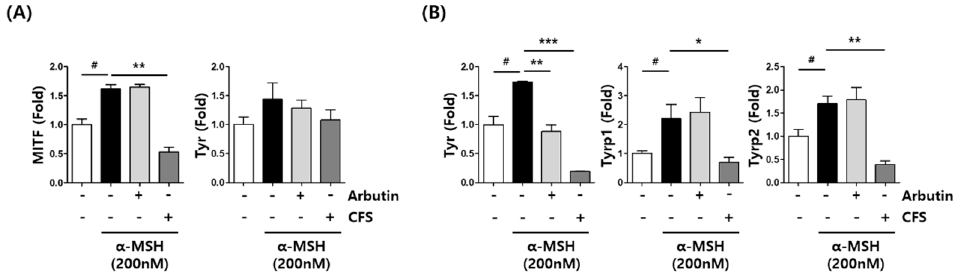
Figure 5. Effect of CFS on melanogenesis-related gene expression in B16-F10 cells. mRNA level of genes determined by real-time RT-PCR. ( A ) Mitf and Tyr , 6 h after treatment. ( B ) Tyr, Tyrp1 , and Tyrp2 , 40 h after treatment. B16-F10 cells were exposed to 200 nM α -MSH in the presence of 1% ( v / v ) CFS or 200 µM Arbutin. CFS: cell-free supernatant from L. gasseri BNR17. Values represent the mean ± SD of three independent experiments. # p < 0.05 compared with control. * p < 0.05, ** p < 0.01, and *** p < 0.001 compared with the α -MSH treated control.